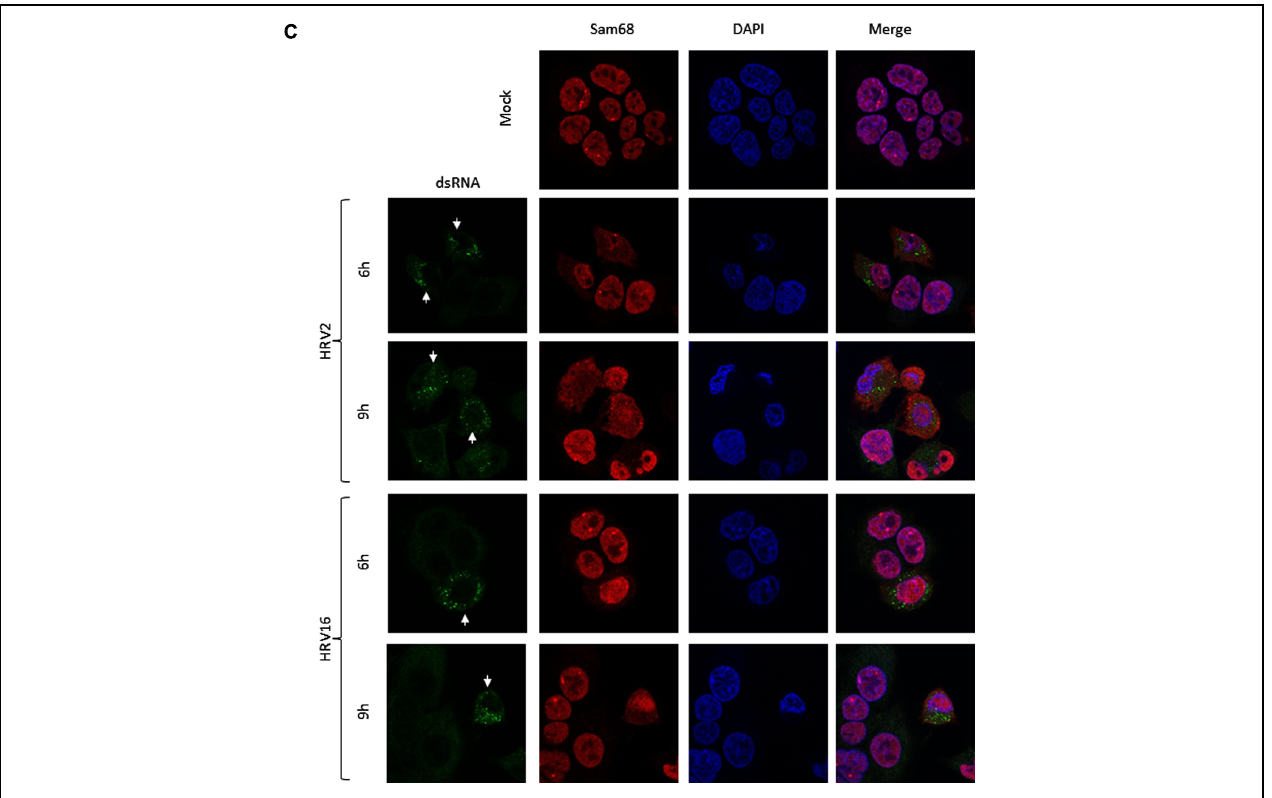
FIGURE 3 | Continued HRV2 and HRV16 infection lead to mislocalization of nuclear proteins. Ohio-HeLa cells grown on coverslips were infected without (mock) or with HRV2 or HRV16 as for Figure 1 ; cells were fixed at the indicated times and permeabilized, and then probed with (A) anti-dsRNA and anti-SC35 antibodies,